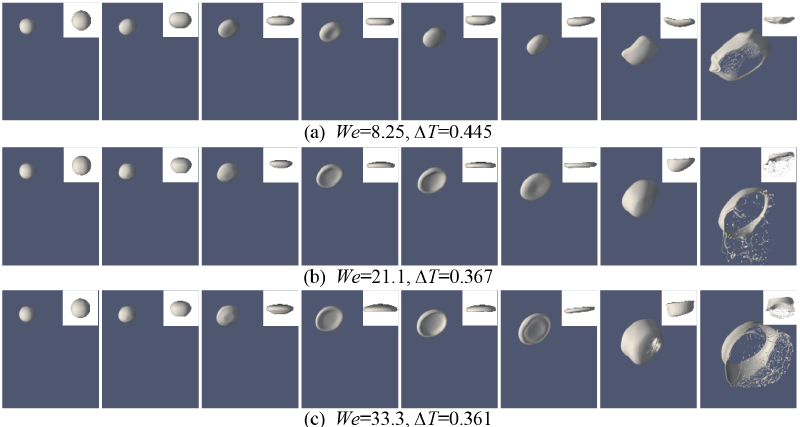
Figure 7. Bag breakup behavior of droplet under di ff erent We numbers ( Oh = 0.002). ( a ) We = 8.25, ∆ T = 0.445; ( b ) We = 21.1, ∆ T = 0.367; ( c ) We = 33.3, ∆ T =